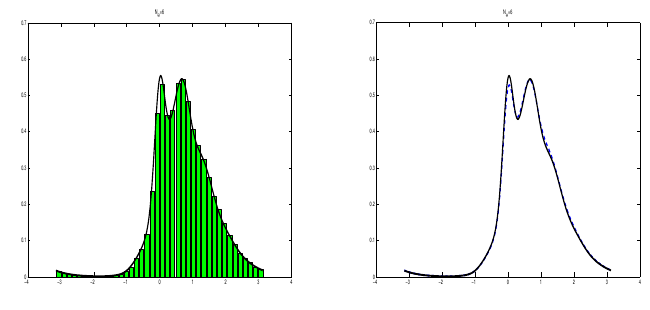
Figure 3. Left, result of the data fitting with N Θ = 6 rates. Histograms: experimental L´evy data collected in 40 bins. Solid line calculated PDF. Right, dashed line calculated PDF with the original 5